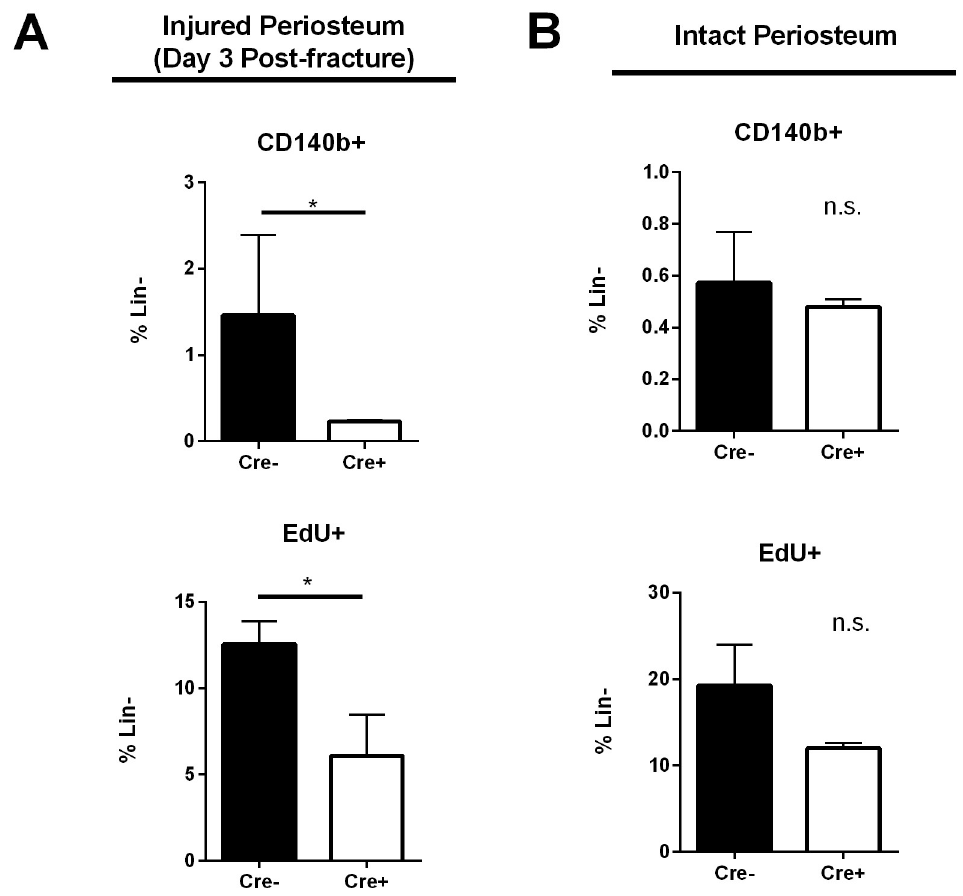
Fig 6. PDGFR β is required for robust periosteal proliferation in vivo after fracture in mice on the gCbl YF background. (A) α SMA-CreERT2/+; PDGFR FL/FL ; gCbl YF mice and PDGFR FL/FL ; gCbl YF controls underwent femoral fracture. Tamoxifen (75 μ g/g body weight) for conditional deletion of PDGFR β was administered at days 0 and 1 prior to sacrifice. EdU (10mM) was injected one day prior to sacrifice. Periosteal cells were isolated from the fracture site and subjected to flow cytometry analyses for proliferating cells and cells expressing PDGFR β . N = 3–4 biological replicates per group. � p < 0.05 (B) Periosteal cells were isolated from intact contralateral femurs and subjected to flow cytometry analyses for proliferating cells and cells expressing PDGFR β . N = 3–4 biological replicates per group. � p < 0.05.